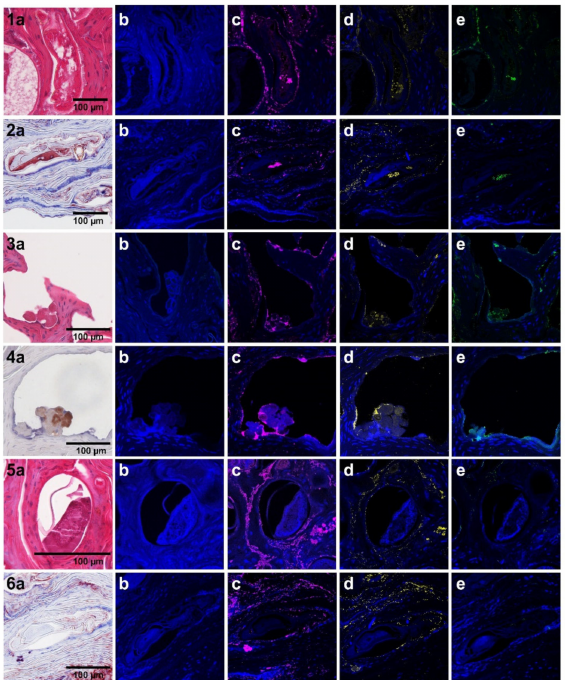
Figure 4. Immunohistological localisation of A. baumannii, S. pyogenes, S. dysgalactiae and S. aureus in S. scabiei var. hominis -infested epidermal tissue by confocal microscopy. Series 1–6 are serial histological sections of scabies mite-infested human skin showing localised bacteria. Series 1 and 2 feature adult S. scabiei var. hominis mites within epidermal burrows; series 3 and 4 show mite faecal pellets; series 5 depicts a laid egg, and series 6 an unlaid egg within an adult female mite. Adjacent section of each series were H&E-stained ( 1a , 3a , and 5a ) or probed with anti-human IgG as a mite gut marker ( 2a , 4a , and 6a ). In these sections, red staining indicates antibody binding to protein. Sections in column ( b ) were probed with pre-immune mouse sera (negative control). Sections in columns ( c – e ) were probed with antibodies specific for S. aureus, A. baumannii, and S. pyogenes/S. dysgalactiae, respectively. The scale bar is 100 µ